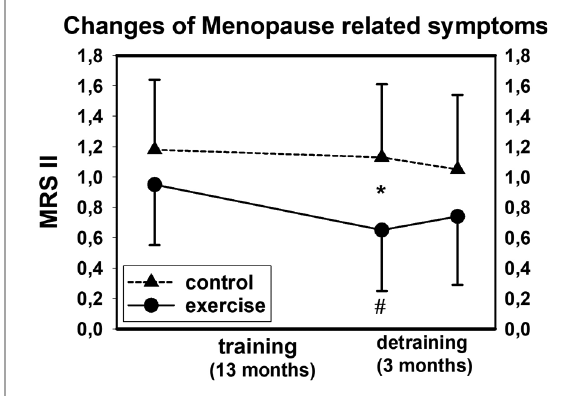
FIGURE 2 Mean values and SD for changes of menopausal symptoms (MRS II) after training and detraining. # p <.05 for within group differences, * p <.05 for between group